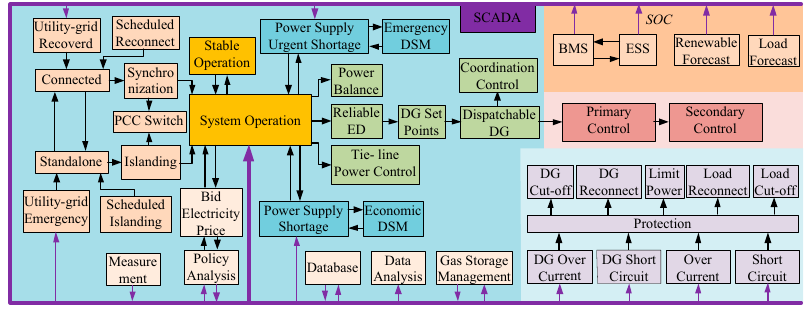
Figure 2. Smart MG overall function.